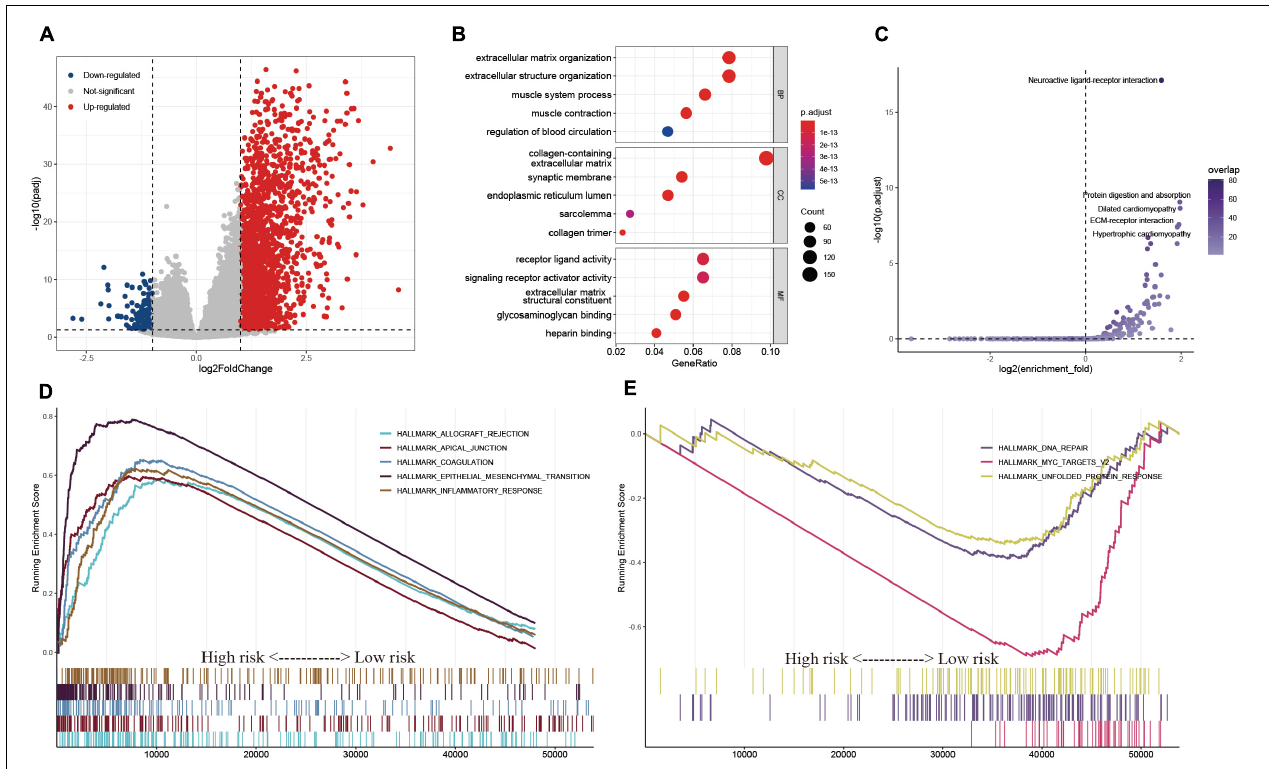
FIGURE 9 | Exploration of the potential regulatory mechanisms resulting in the differences of TIME between the low- and high-risk groups. (A) Volcano plot of DEGs between the low- and high-risk groups. (B,C) GO (B) and KEGG (C) enrichment analyses of DEGs. (D,E) Hallmarks were significantly enriched in the high-risk (D) and low-risk (E)